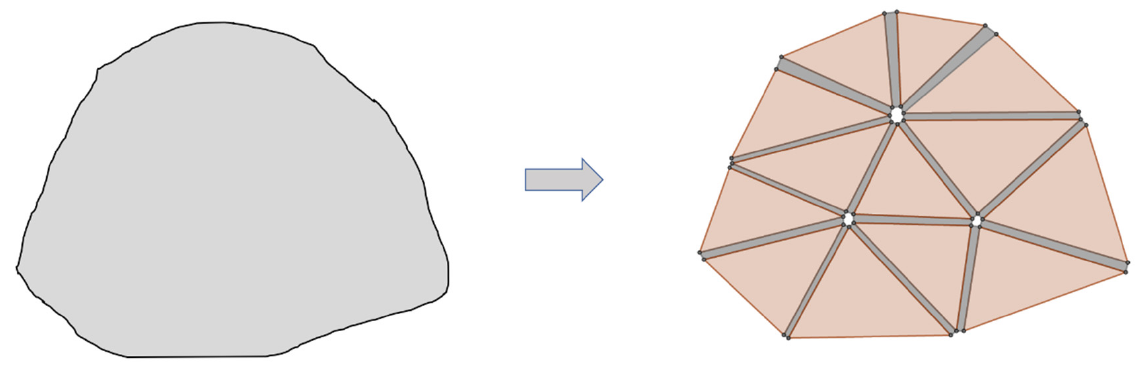
Figure 2. Meshing in FDEM